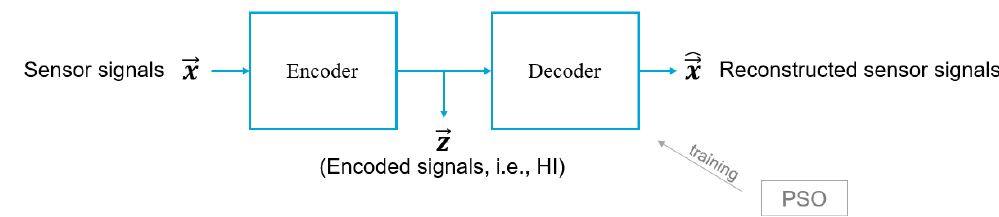
Figure 3. Architecture of the